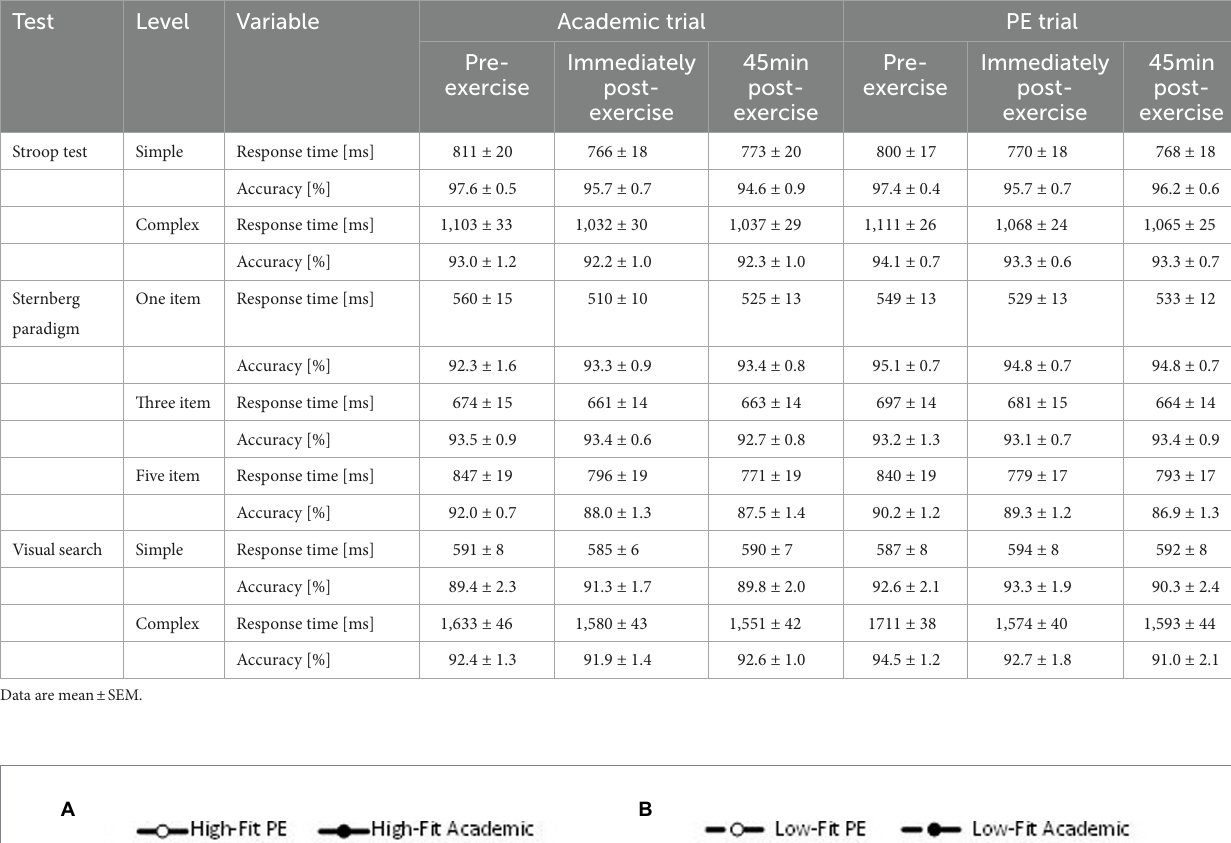
TABLE 3 Cognitive function data across the academic and PE trials.